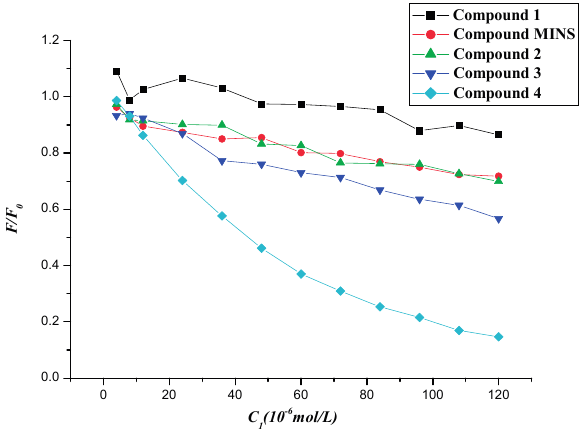
Figure 6. Fluorescence quenching ratio ( F / F 0 ) of BSA by compounds 1 – 4 and MINS at room